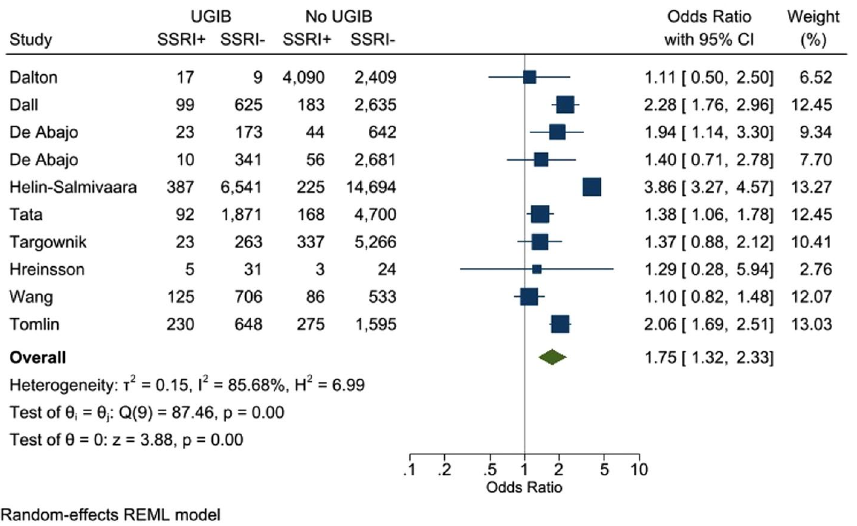
Figure 2. Forrest plot showing odds of upper gastrointestinal bleeding in patients with concomitant use of SSRIs and NSAIDs versus NSIADs alone.